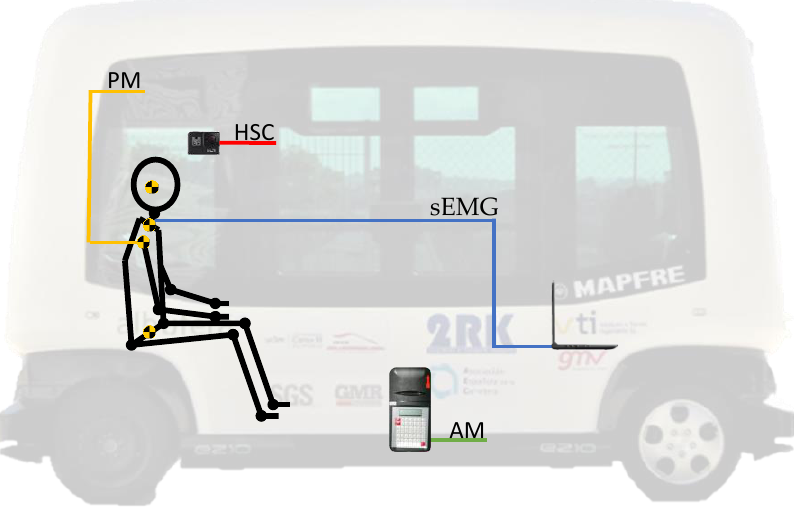
Figure 4. Devices used in the emergency braking test. PM: Position Markers, HSC: High-Speed Camera, AM: Accelerometer, sEMG: Sensors of Surface Electromyography. Based on [20].